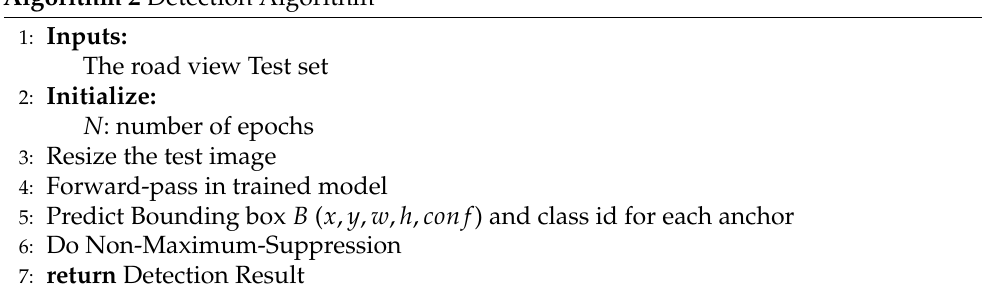
Algorithm 2 Detection